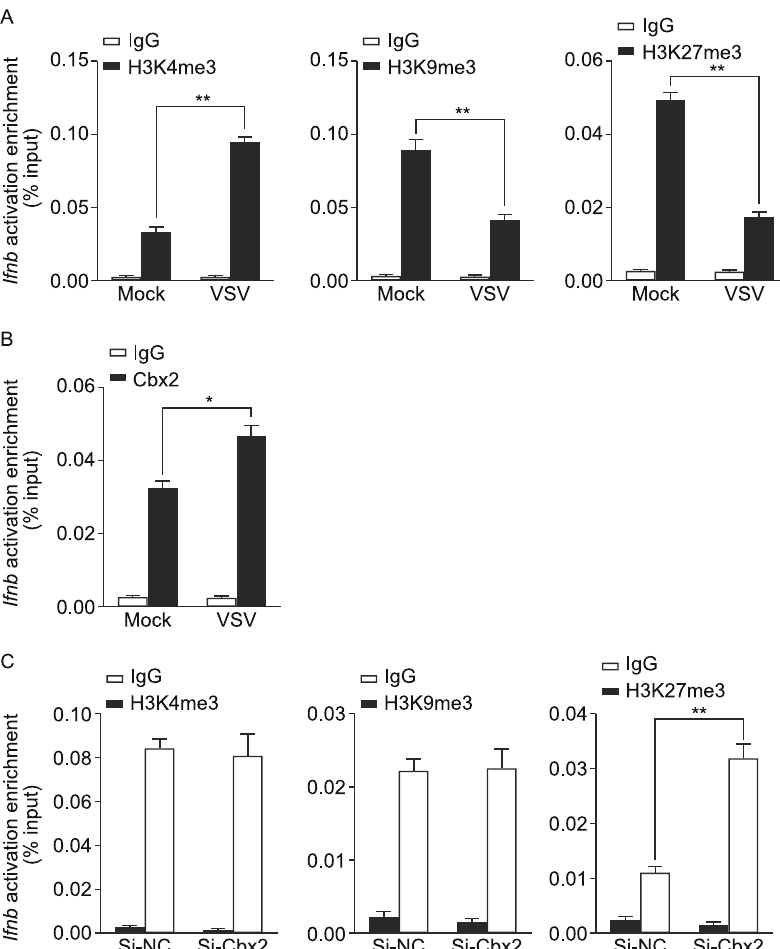
Figure 5. Cbx2 suppresses the methylation3 of H3K27 on the Ifnb promoter. (A) ChIP analysis of methylated histones at the Ifnb promoter in RAW264.7 cells left unstimulated (mock) or infected with VSV (MOI = 10) for 6 h. (B) ChIP analysis of Cbx2 at the Ifnb promoter in RAW264.7 cells left unstimulated (mock) or infected with VSV (MOI = 10) for 6 h. (C) ChIP analysis of methylated histones at the Ifnb promoter in mouse peritoneal macrophages transfected with Si-NC or Si-Cbx2 for 48 h, and then infected with VSV (MOI = 10) for 6 h. All data are from three independent experiments (mean ± SEM) of technical triplicates. Data are representative of three independent experiments with similar results. * P < 0.05; ** P